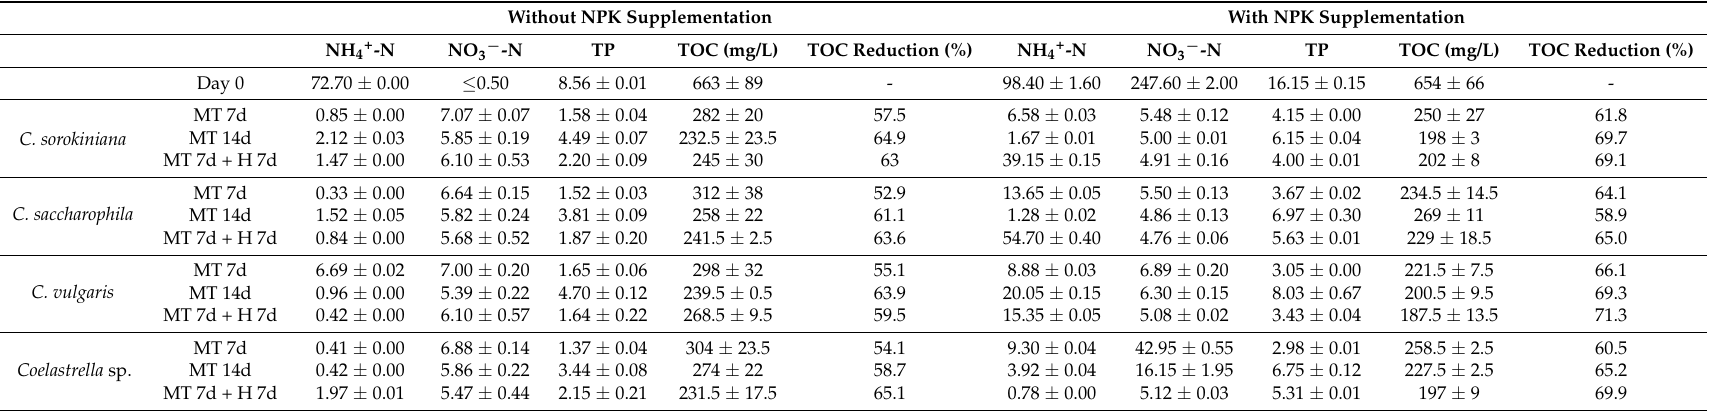
Table 1. Nutrients, ammonium (NH 4+ -N), nitrate (NO 3 − -N), total phosphorous (TP), and total organic carbon (TOC), concentrations (mg L − 1 ) in the birch hydrolysate and dairy effluent medium, with and without nitrogen, phosphorus, and potassium (NPK) supplementation, at day 0, day 7 (mixotrophic growth—MT 7d), and day 14 (mixotrophic and two stage mixotrophic/heterotrophic growth (H)—MT 14d and MT 7d + H 7d) in the cultures of C. sorokiniana , C. saccharophila , C. vulgaris, and Coelastrella sp. Values are expressed as mean ± standard deviation ( n = 2).